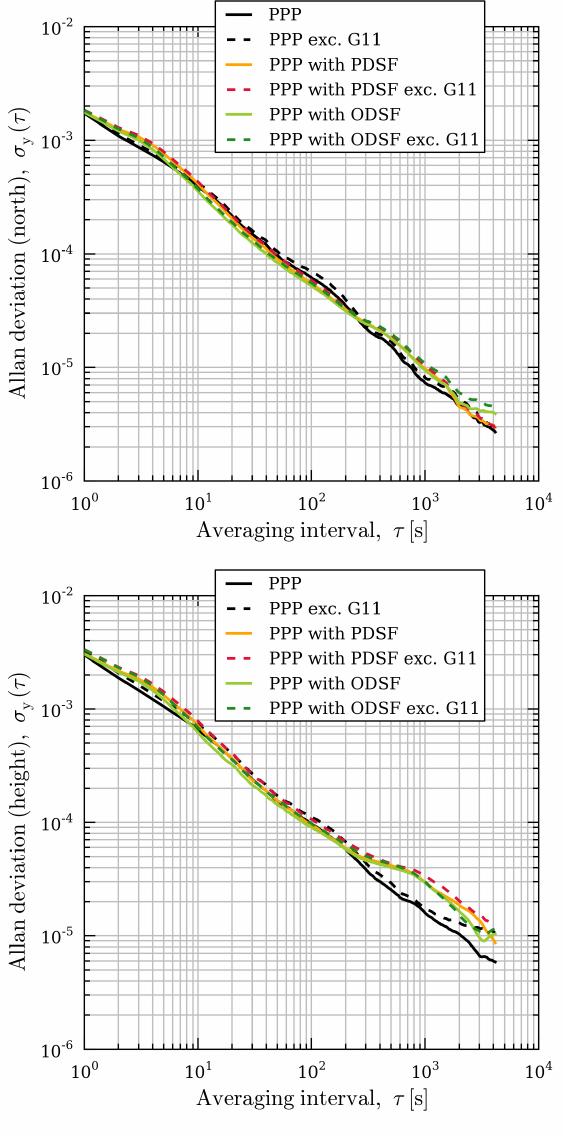
Figure 14: Allan deviation plots of the corresponding northing (top) and height (bottom) position time series at station UCL between 15:17 and 21:04 on August 31 2013 shown in Fig. 13.